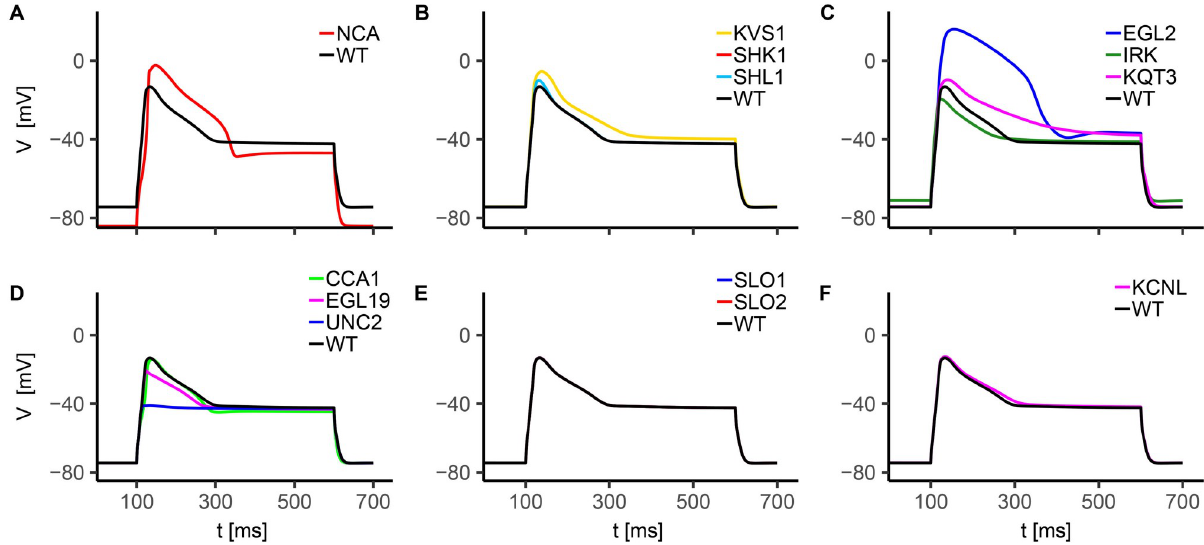
Fig 6. In silico AWC ON knockouts voltage response to current injection. The stimulation protocol consists in a single 15 pA current step with a duration of 500 ms. The holding current is I h = 0pA. Each knockout is obtained by suppressing the contribution of the selected current, leaving unchanged the other conductances. In panels A-F we report the response of NCA (A), voltage-gated potassium channels (B and C), voltage-gated calcium channels (D), and calcium-regulated potassium channels (E and F) knockouts.